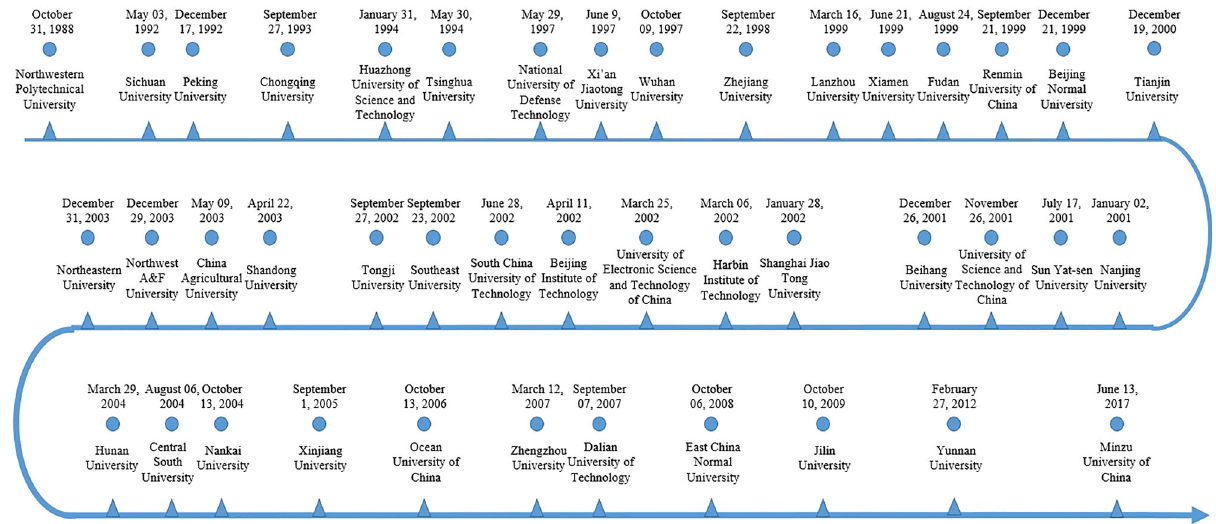
Fig. 1 The date of the fi rst trademark application for the 42 fi rst-class universities. Various universities have experienced different trademark “ awakening ” time. Some universities started taking trademarks seriously early on, while some did not begin registering trademarks until a few years ago. HUMANITIES AND SOCIAL SCIENCES COMMUNICATIONS| (2022) 9:254